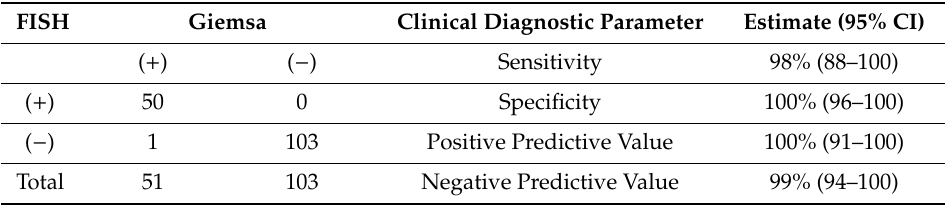
Table 2. Estimated clinical diagnostic parameters for the Babesia genus FISH